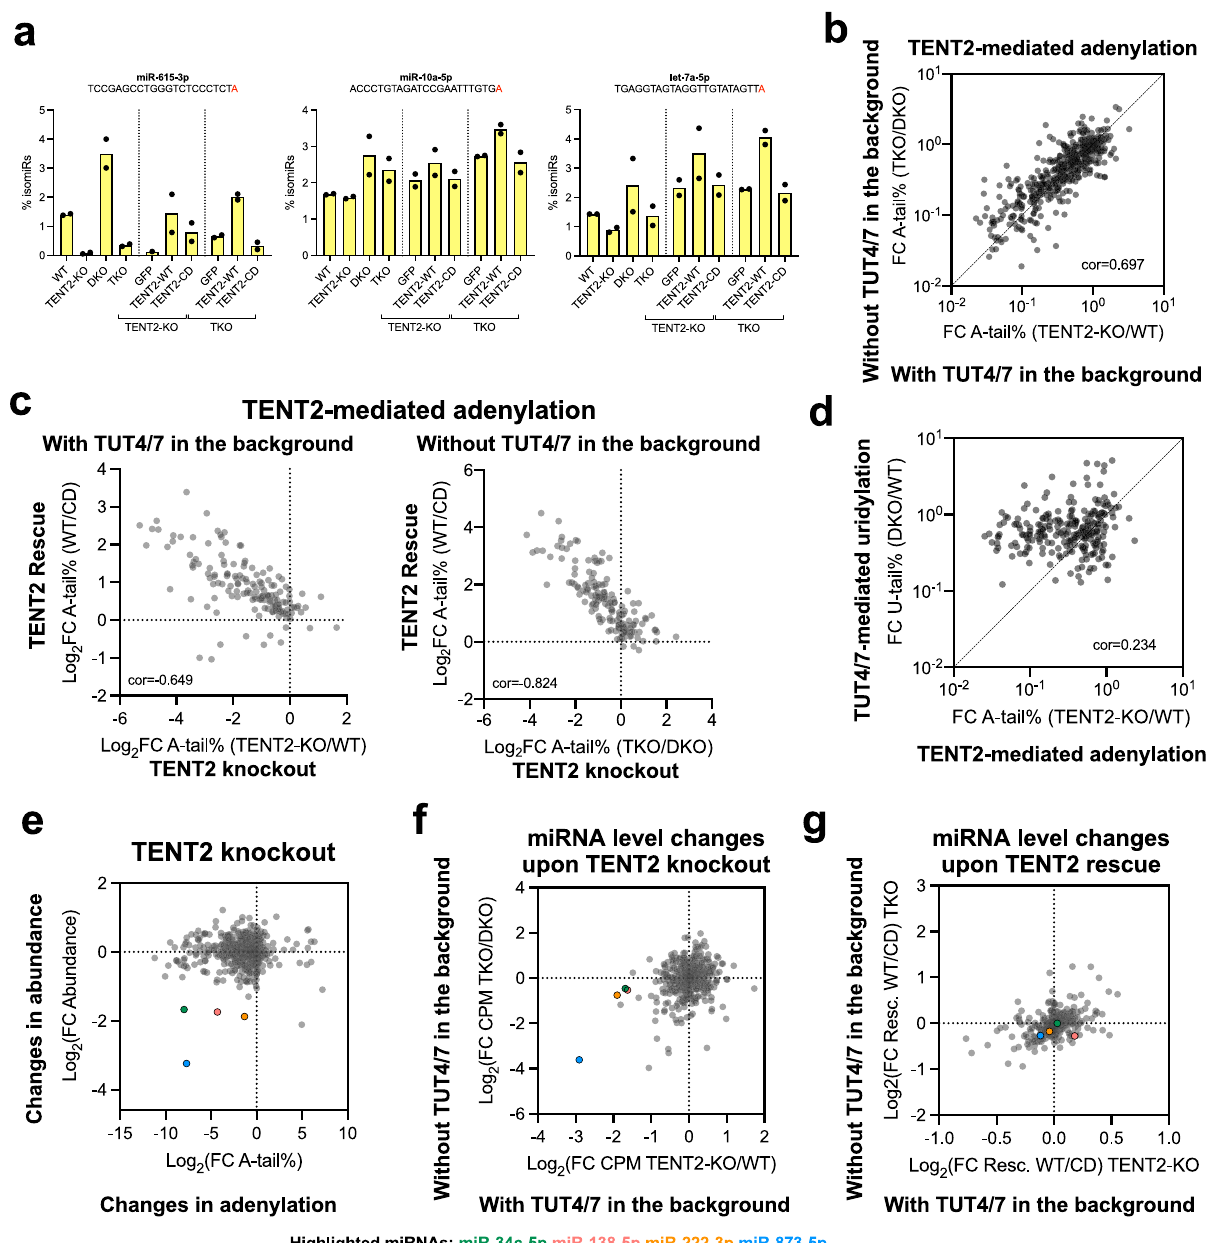
Fig. 4 | TENT2 selectively modi fi es mature miRNAs but has minimal impact on miRNA abundance. a Percentage of adenylated isomiRs across different knock- outs and rescues. Sequences indicate templated nucleotides (black) and NT ade- nylation(red).Dotsrepresentthevaluesobtainedinthetwoindependentcolonies or biological replicates. b , c Scatter plot of fold-change in the percentage of NT A-tail between different genetic backgrounds and rescues. d Scatter plot of fold- change in the percentage of NT A-tail and U-tail (matched isomiRs) between